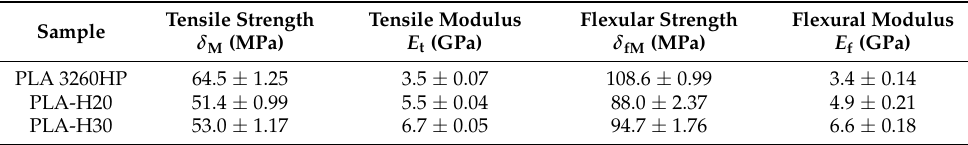
Table 7. Tensile and flexular properties of PLA/hemp composites.